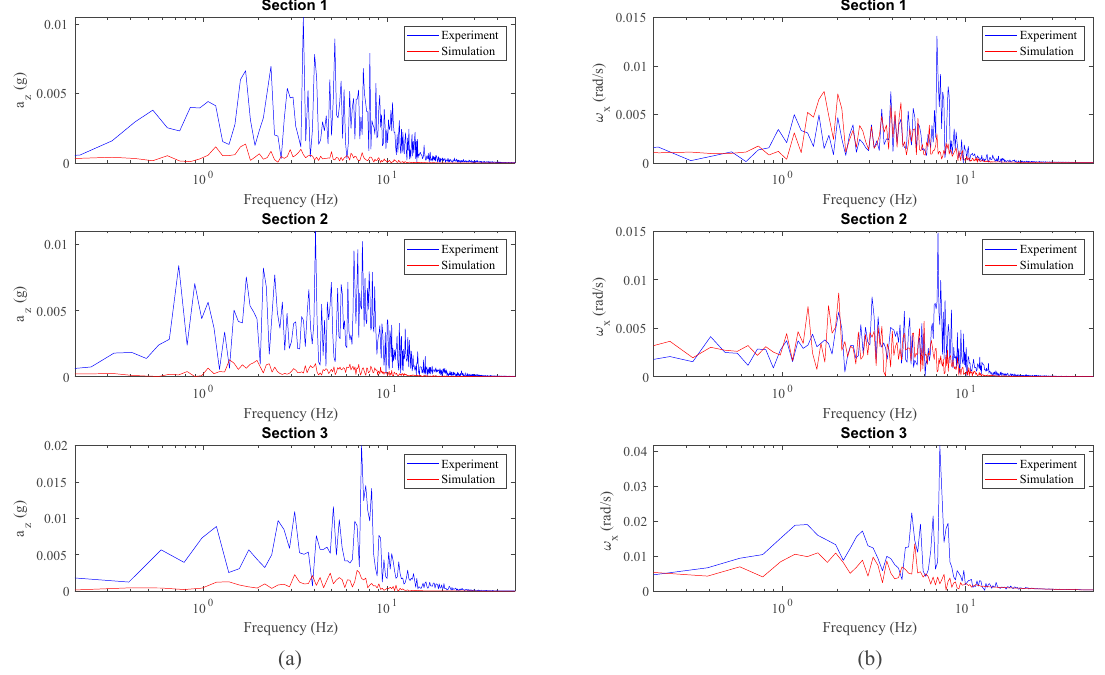
Figure 13. Frequency analysis of vertical acceleration ( a ) and roll angular velocity ( b ) data from inertial sensors on the